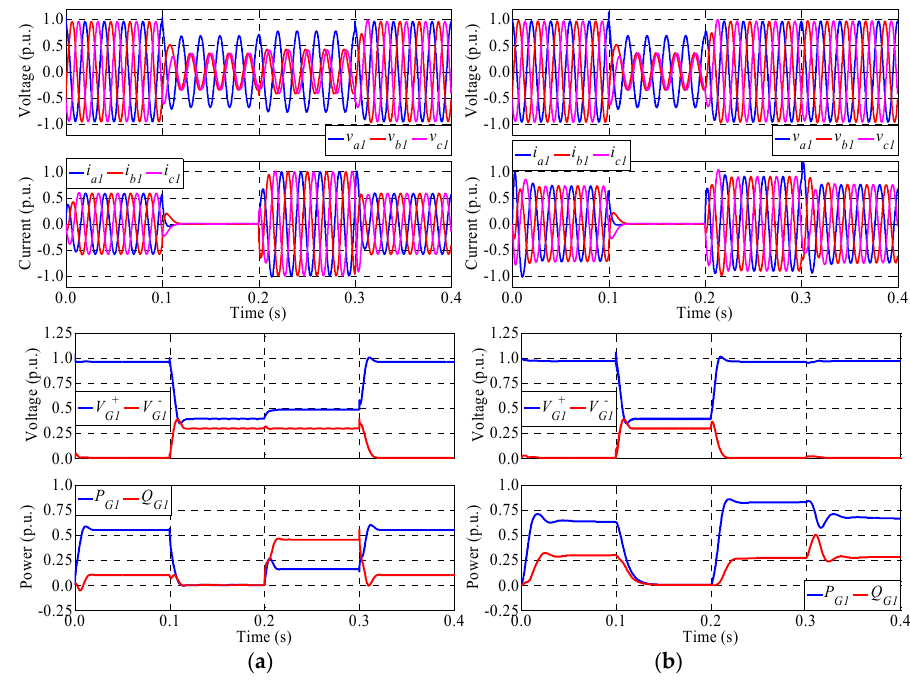
Figure 11. Main waveforms of generator 1 using the ( a ) GCCS1 and ( b ) IVS control schemes for type II voltage sag.